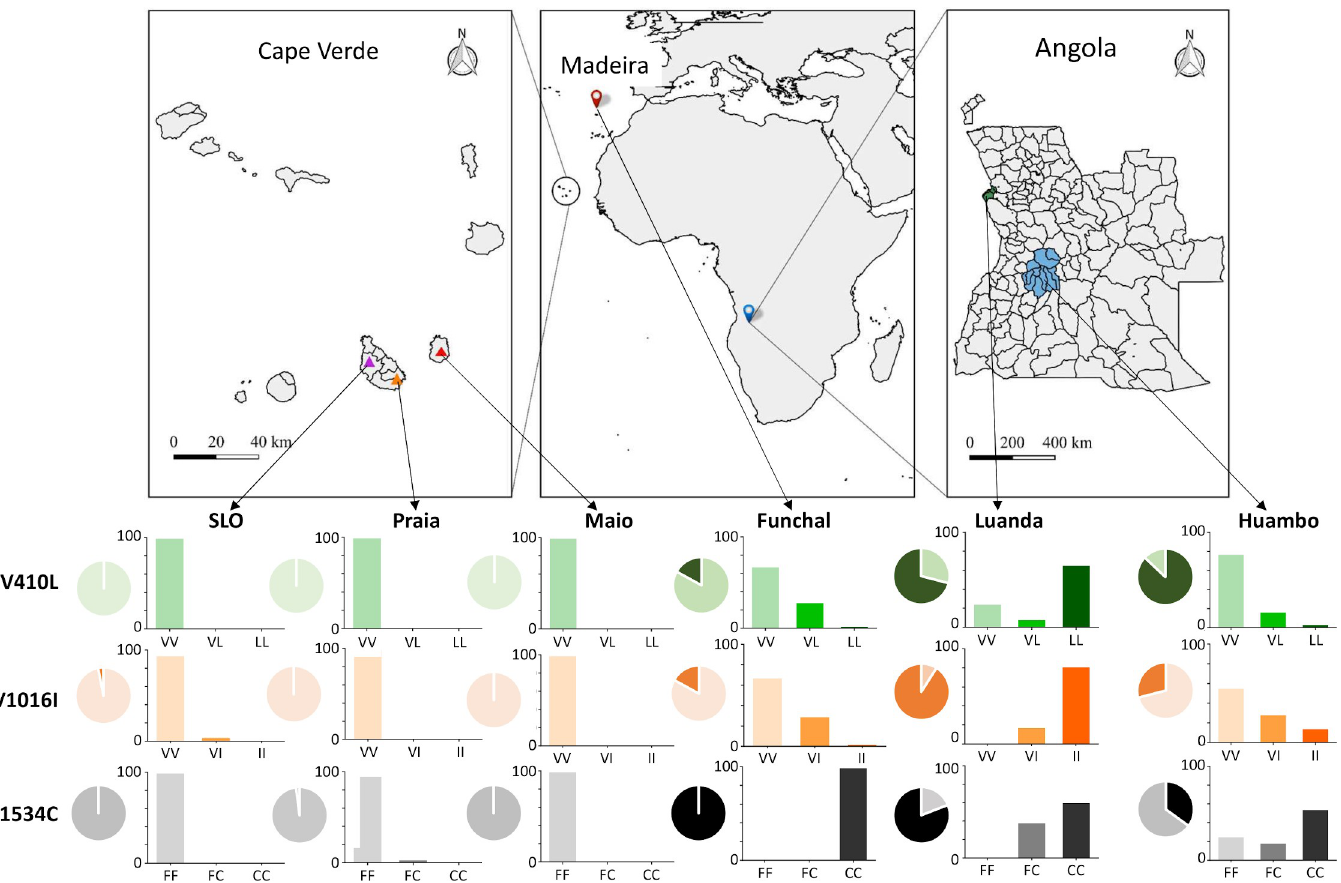
Fig 1. Collection sites, allele frequencies (pie charts) and genotypic frequencies (bar charts) for each of the kdr mutations analysed. In each allele frequency pie chart, light colour represents the wild-type (susceptible allele) and dark colour the resistance-associated allele. Map source: edited in QGIS v.3.8.0 (July,